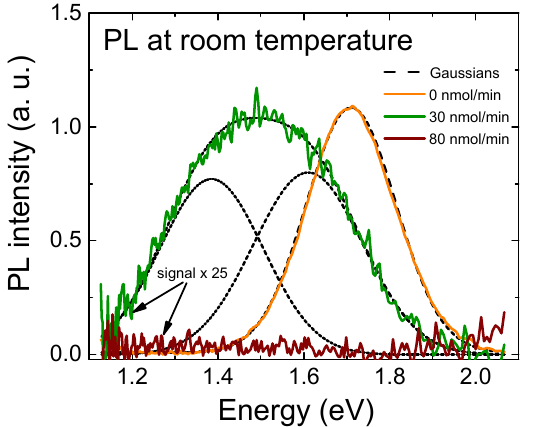
Figure 11. InAlN room temperature photoluminescence for different Cp 2 Mg flow. Combination of two Gaussian curves fit the 30 nmol/min sample.